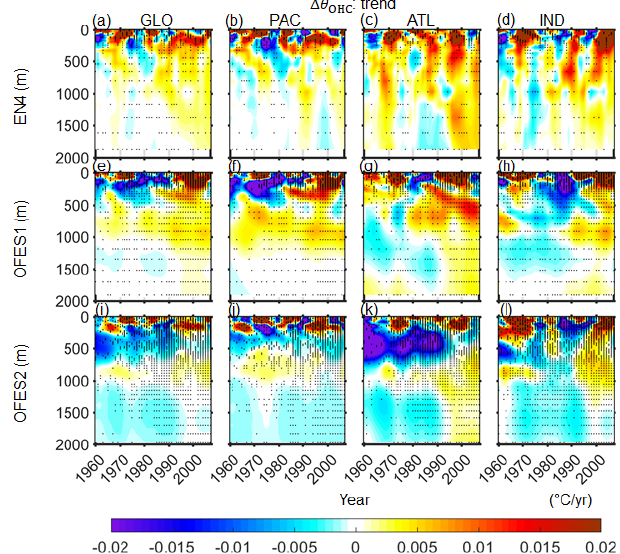
Figure 11. Depth–time patterns of the horizontally averaged poten- tial temperature change (cid:49)θ OHC for (left to right) the global, Pa- cific, Atlantic, and Indian oceans. Top to bottom: EN4, OFES1, and OFES2. Horizontal axis: year; vertical axis: depth in